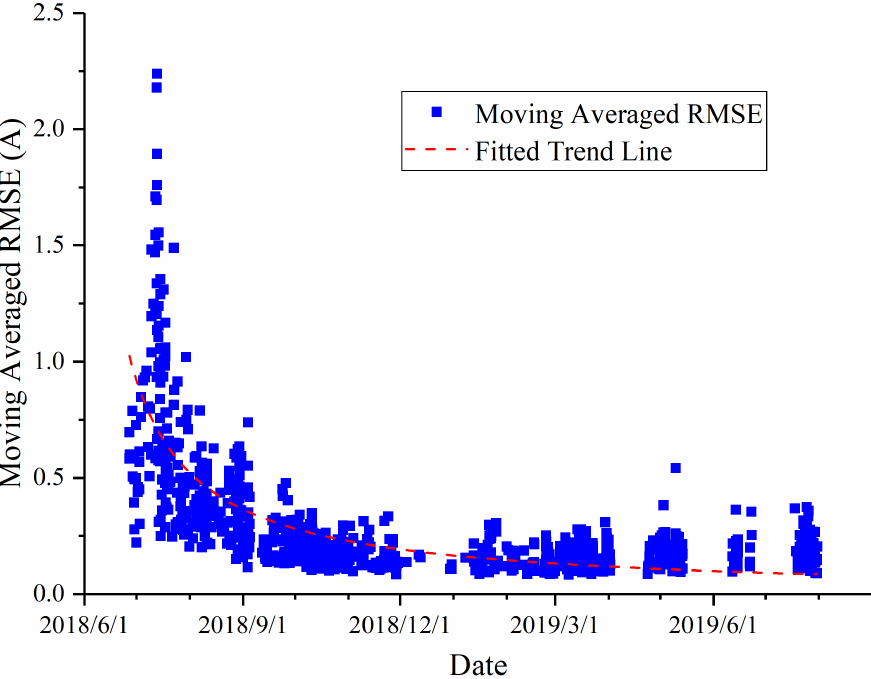
Figure 6. Convergence trend of